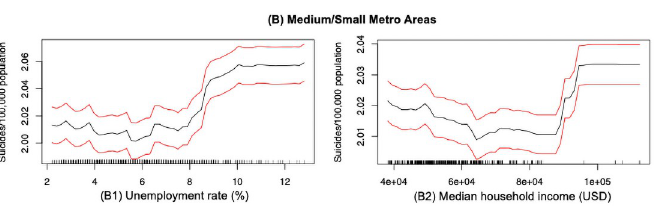
Fig 10. Suicide mortality rate in economics for (B) Medium/small metro areas only. Rug lines on the x axis indicate prevalence of data points; black curve is the average marginal effect of the predictor variable; red lines indicate the 95% confidence